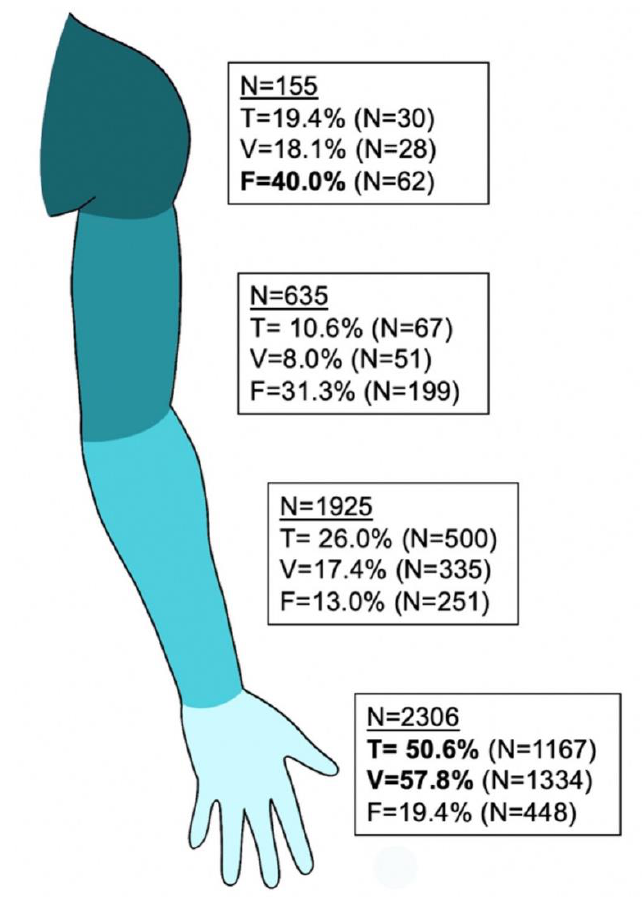
Figure 3. Concomitant injuries on the upper extremity. Displayed are injuries on different levels with concomitant tendon or muscle (T), blood vessel injuries (V) or fracture (F). The number of patients with at least one e.g., tendon injuries, is shown.